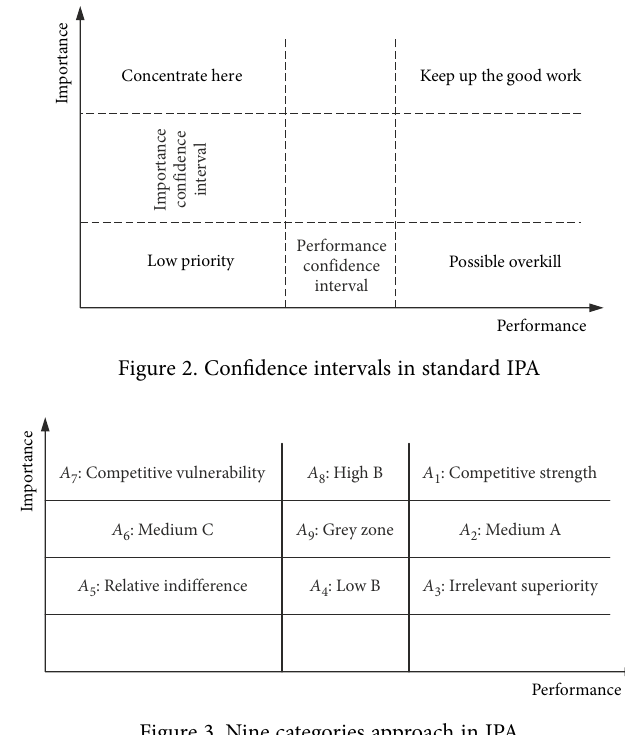
Figure 3. Nine categories approach in